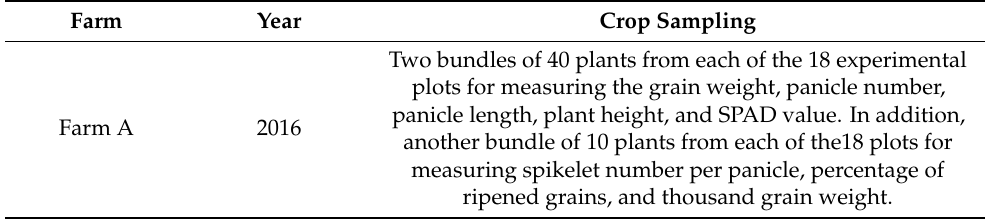
Table 2. Sample number of plants from each